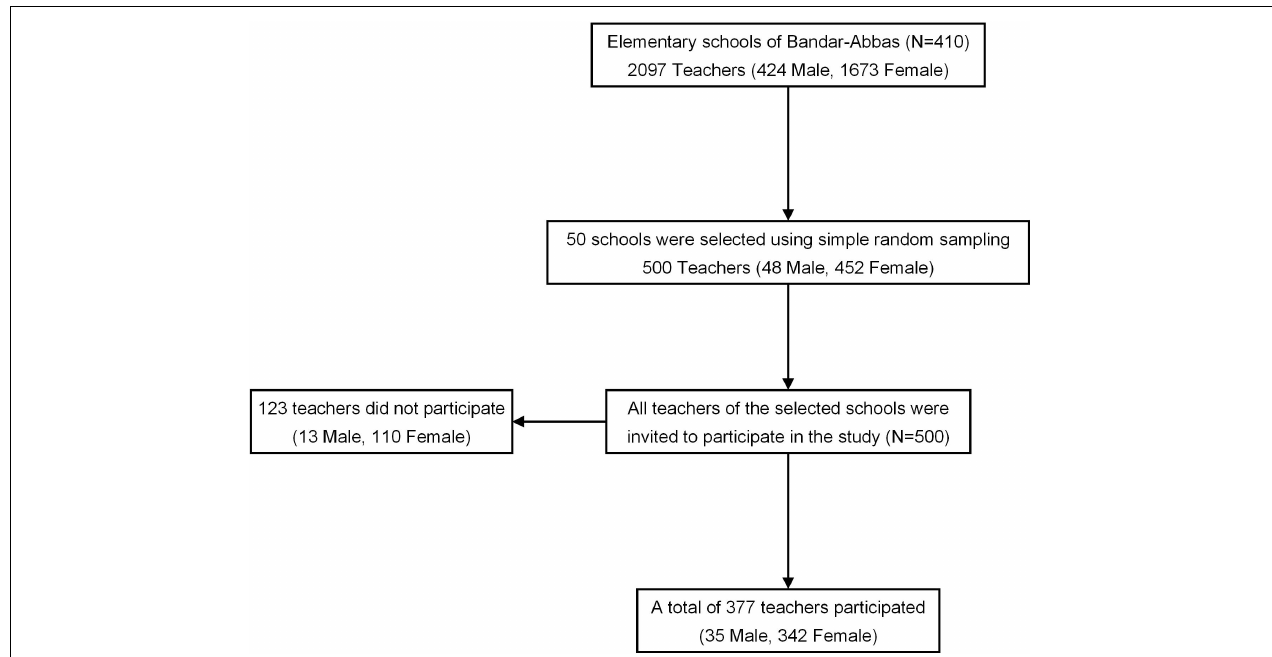
FIGURE 1 | Flow chart of selecting the participants among elementary school teachers of